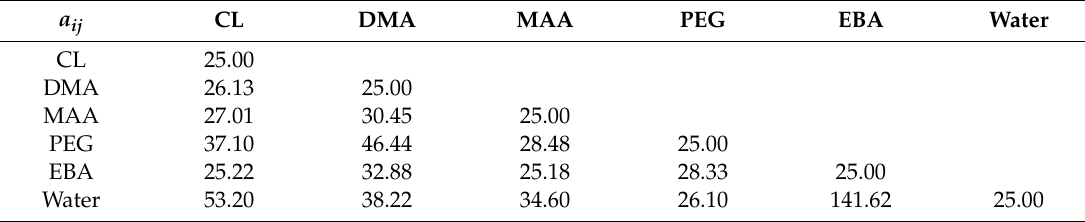
Table 3. The interaction parameters 𝑎 𝑖𝑗 between the different beads.